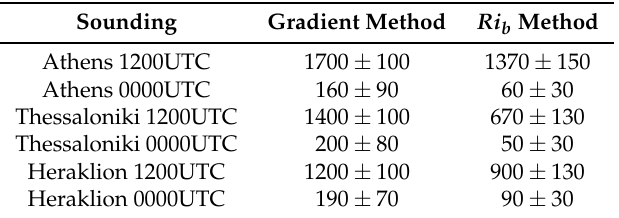
Figure 6. The same as in Figure 5 but for the 1200UTC soundings over Thessaloniki. Table 1. Median values for the PBLH (in m) over all three sites estimated using the gradient and the bulk Richardson number methods. The error is the mean error due to the finite vertical spacing of the soundings as described in Section